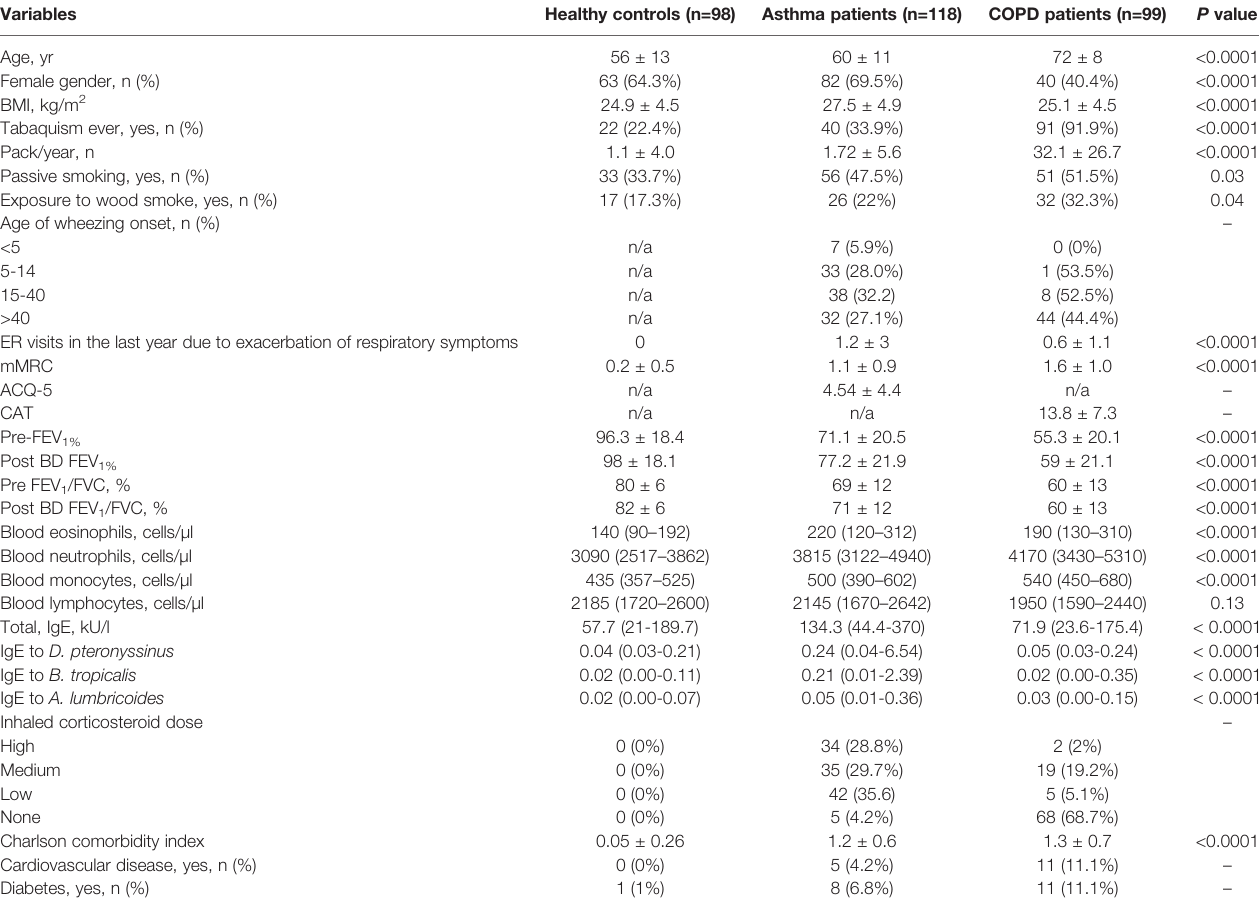
TABLE 1 | Demographic and clinical characteristics of study subjects.